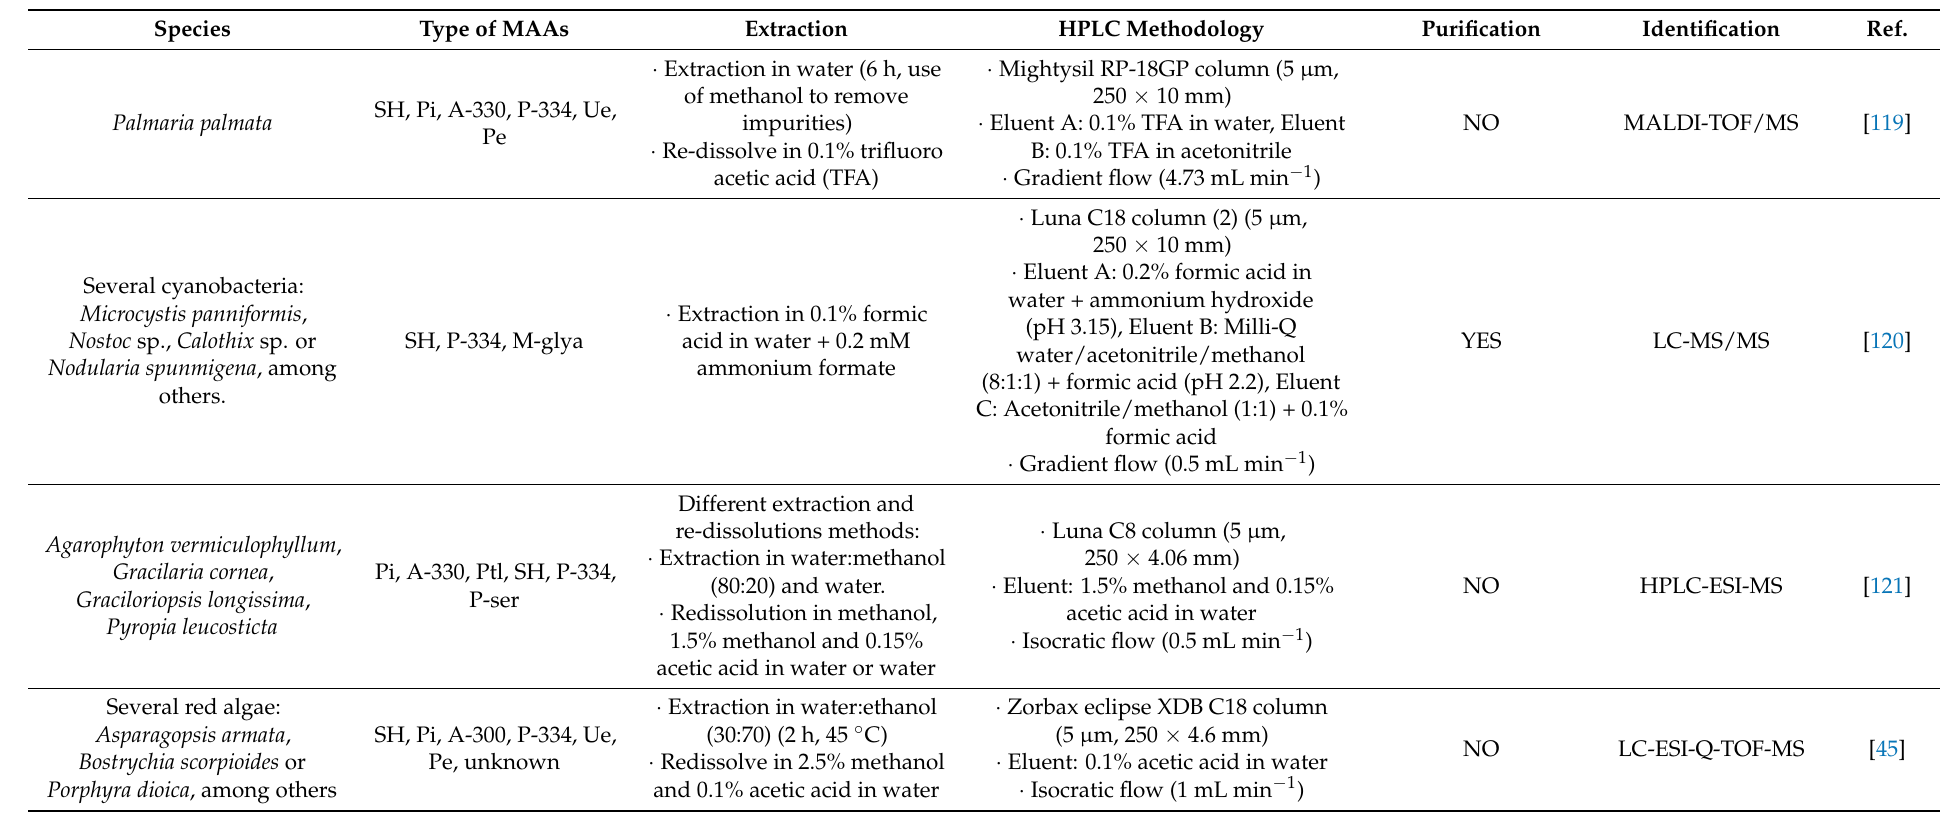
Table 1. Summary of the most recently used methodologies for identification and characterization of MAAs. Asterina 330 (A-330); aplysiapalythine A (APA); aplysiapalythine-B (APB); catenelline (CLL); E-palythenic acid (EPA); mycosporine-glycine (M-gly); mycosporine-glycine-alanine (M-gly:a); mycosporine-2-glycine (M-2-gly); mycosporine-methylamine-serine (M-MA:ser); mycosporine methylamine threonine (MM-thr); mycosporine sulfate ester (MSE); mycosporine-serinol (M-ser(OH)); mycosporine taurine (M-tau); porphyra 334 (P-334); palythene (Pe); palythine (Pi); palythine serine (P-ser); palythine-serine sulfate (PSS); palythinol (Ptl); shinorine (SH); shinorine methyl ester (SME); usujirene (Ue); Z-palythenic acid (ZPA). Matrix assisted laser desorption ionization-time of flight mass spectrometry (MALDI-TOF/MS); Liquid chromatography-tandem mass spectrometry (LC-MS/MS); Nuclear Magnetic Resonance (RMN 1D (one dimension) and 2D (two dimensions)); Quadrupole time-of-flight mass spectrometry (QTOFMS); Electrospray ionization-mass spectrometry (ESI–MS); Liquid chromatography-mass spectrometry (LC-MS); Homonuclear Correlation Spectroscopy (COSY); Hydrophilic interaction liquid chromatography (HILIC); Photodiode-array (PDA); Heteronuclear multiple quantum correlation (HMQC); Hydrogen/Deuterium (H/D). Extraction HPLC Methodology Purification